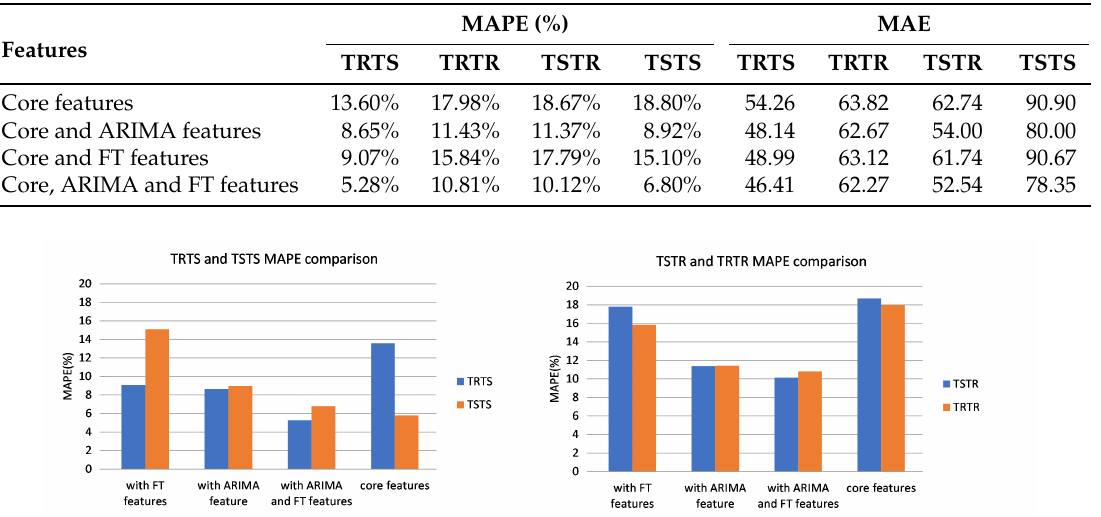
Table 1. Train on Real, Test on Synthetic (TRTS), Train on Real, Test on Real (TRTR), Train on Synthetic, Test on Real (TSTR), and Train on Synthetic, Test on Synthetic (TSTS) accuracy for R-GAN (UCI data set).